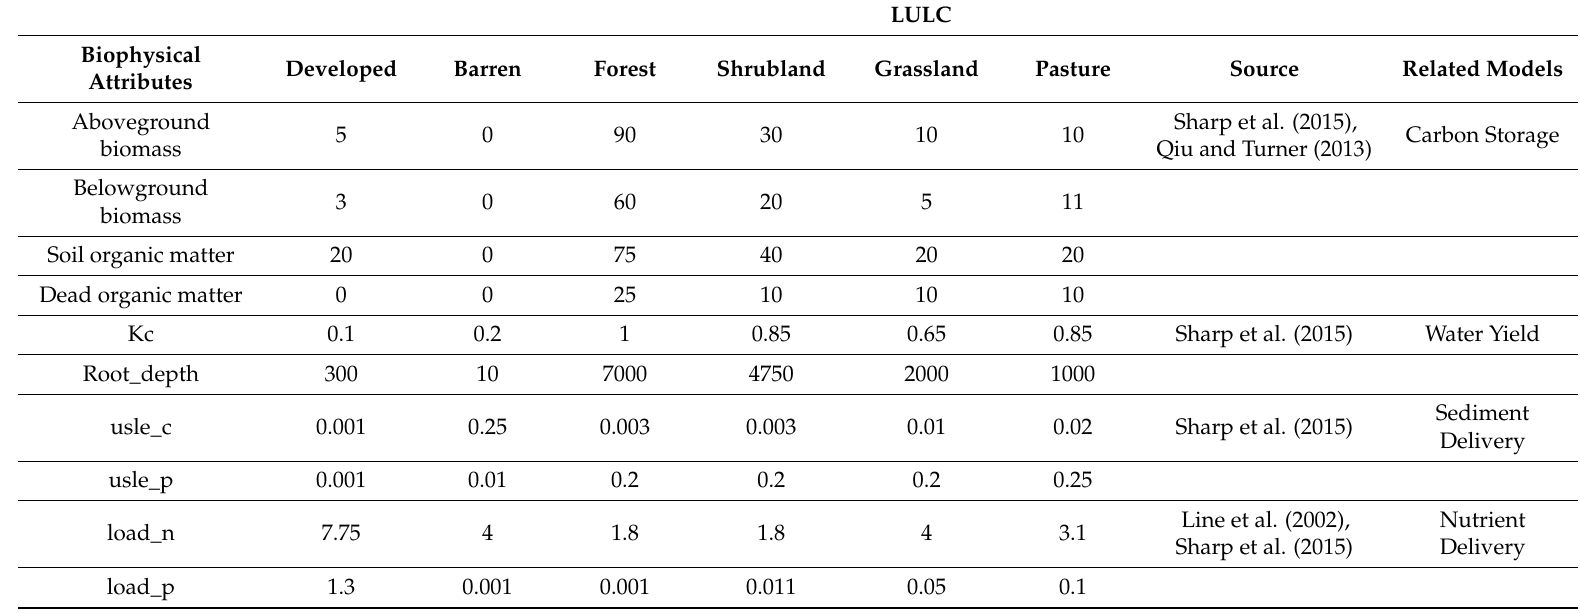
Table A2. Carbon pool estimates and other biophysical attributes used for the InVEST models. LULC Shrubland Grassland Pasture Source Related